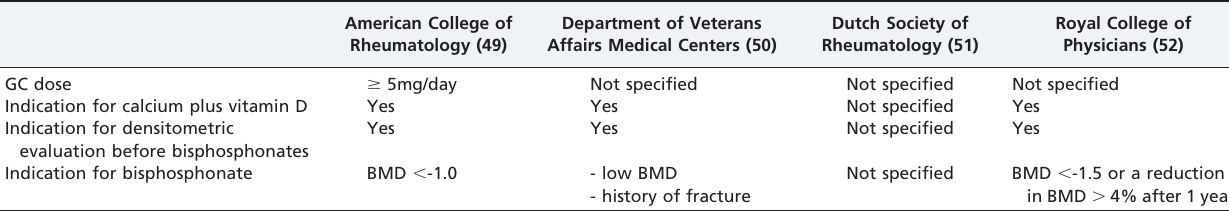
Table 5 - Guidelines for the treatment of